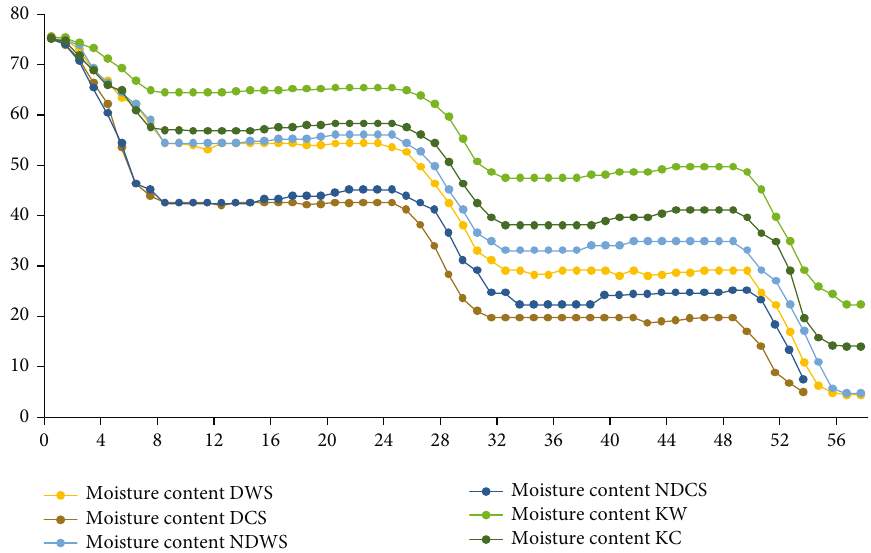
Figure 4: Moisture content (wb%) versus drying time (h). DWS: whole pods dried using desiccant in solar drying; NDWS: whole pods dried without using desiccant in solar drying; KW: whole pods dried using natural convection solar drying; DCS: half chili pods dried using desiccant in solar drying; NDCS: half chili pods without using desiccant in solar drying; KC: half chili pods dried using natural convection solar drying. Table 2: Beta-carotene, moisture content, vitamin C, and ash content of chili powder. Sample Beta-carotene (mg/100 g)